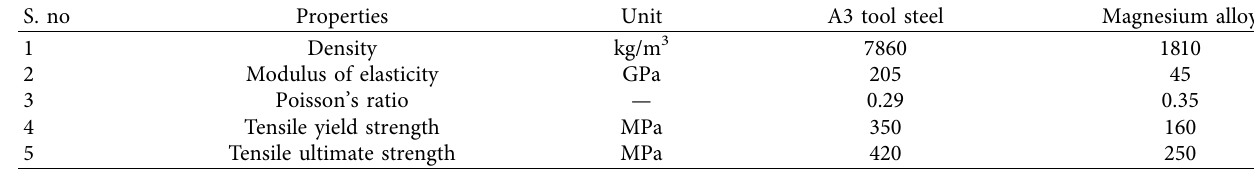
Table 2: Properties of A3 steel and magnesium